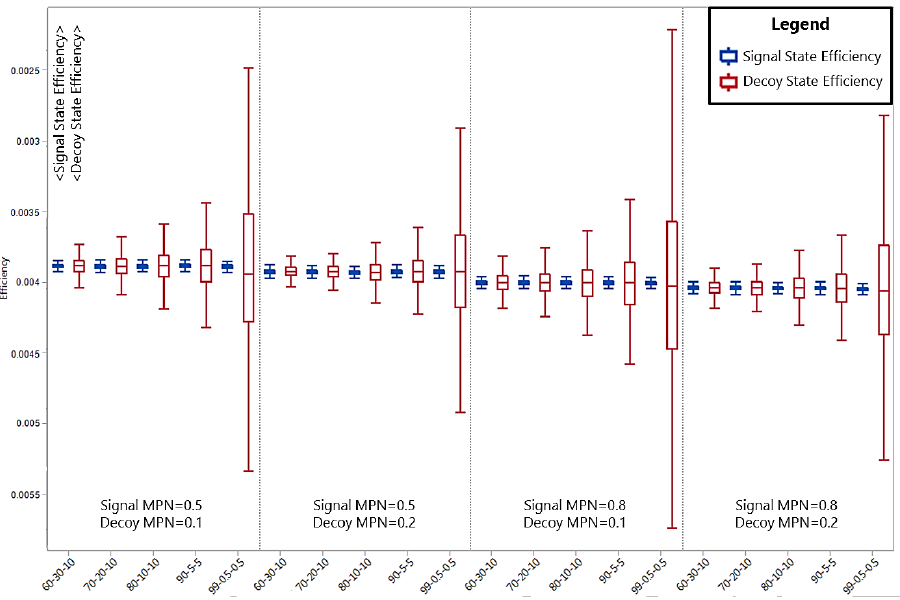
Figure 4. Simulation results are shown for the for the 50 km decoy state protocol configurations examined when operating under normal conditions. In each configuration studied, the signal and decoy state efficiencies are the same 𝜂 𝑠𝑖𝑔𝑛𝑎𝑙 = 𝜂 𝑑𝑒𝑐𝑜𝑦 ± Δ (within expected variation tolerances).